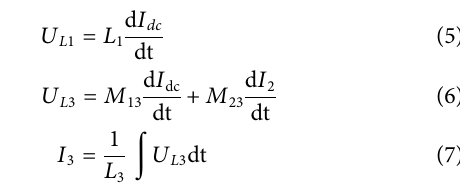
FIGURE 8 | Power acquisition process of the SPSSs. (A) Current waveforms of the three SSFCLs. (B) SPSS voltage acquisition process. (C) SPSS voltage of the three self-powered